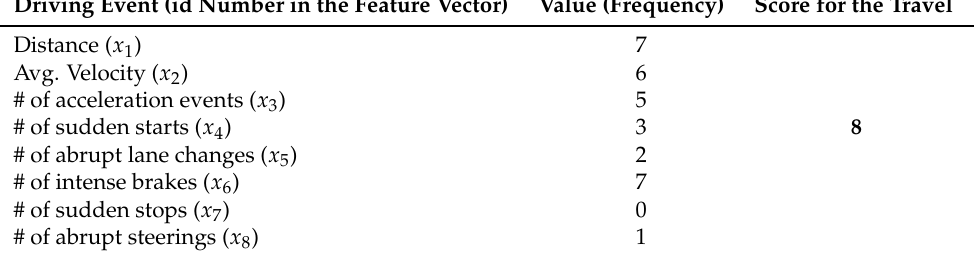
Table 1. A sample of the survey used to evaluate each driving event as safe or unsafe, based on the frequency of each